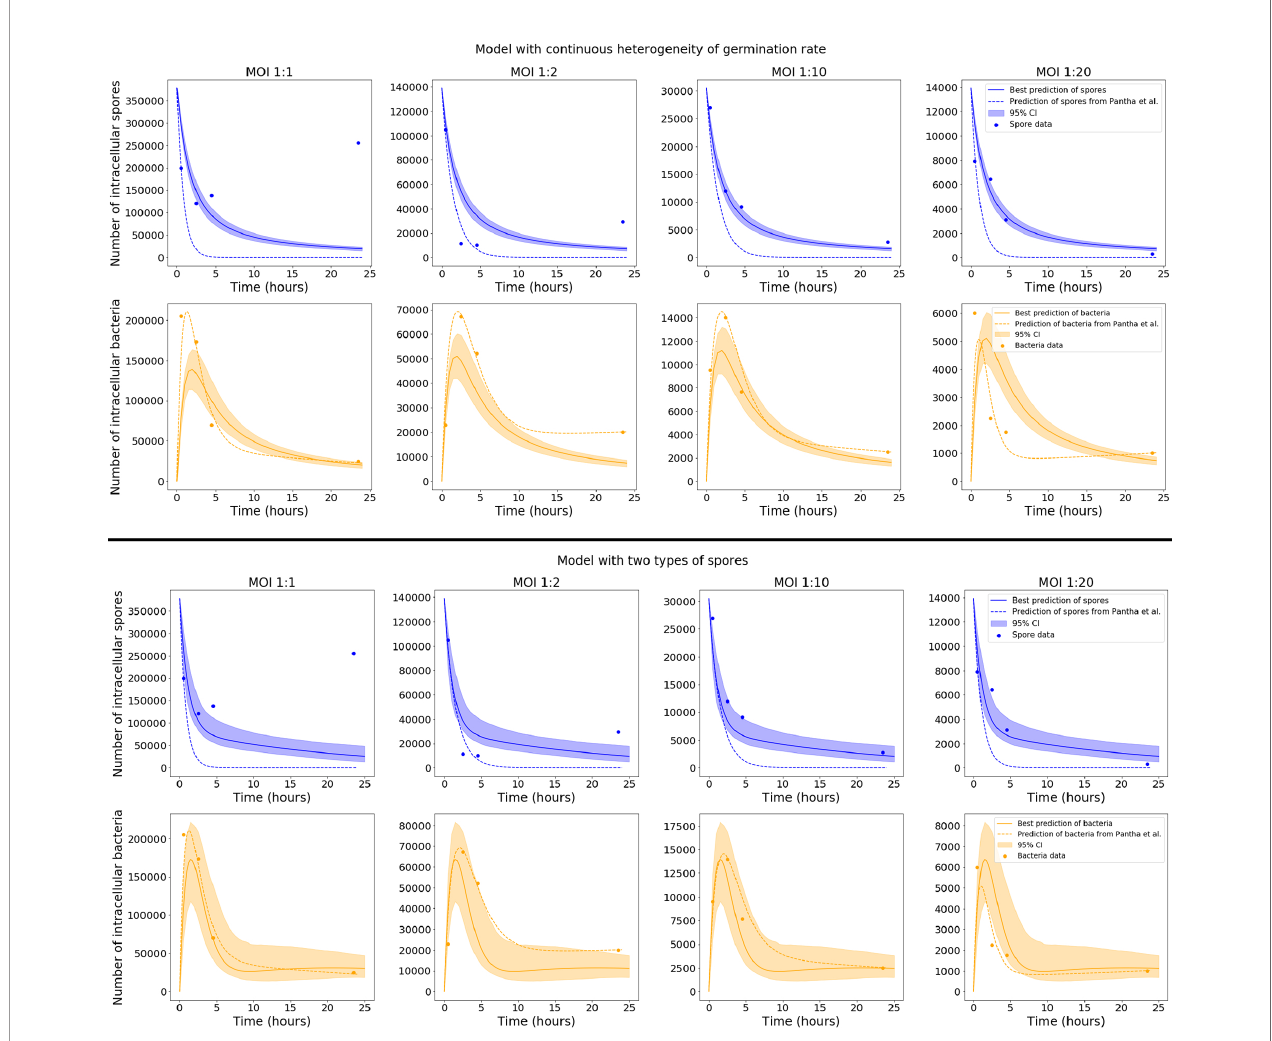
FIGURE 4 | Plots showing the best predictions (solid lines) and pointwise 95% credible intervals (shaded regions) of the time-courses for the mean number of intracellular spores and bacteria, for the model with continuous heterogeneity of germination rate (top), and the model with two types of spores (bottom). The best predictions are the model outputs obtained by using the accepted parameter set with the smallest distance to the data, and the pointwise 95% credible intervals show the uncertainty in those predictions, given the range of parameter values in the 10 3 accepted parameter sets from the fi nal iteration of ABC-SMC. The predictions from the model by Pantha et al., using separate sets of parameter estimates for each MOI, are shown as dashed lines. For our model, only the data for MOI 1:2, 1:10 and 1:20 were used in the ABC-SMC to calibrate model parameters. The comparison of the model predictions with the MOI 1:1 data is shown here as a qualitative model